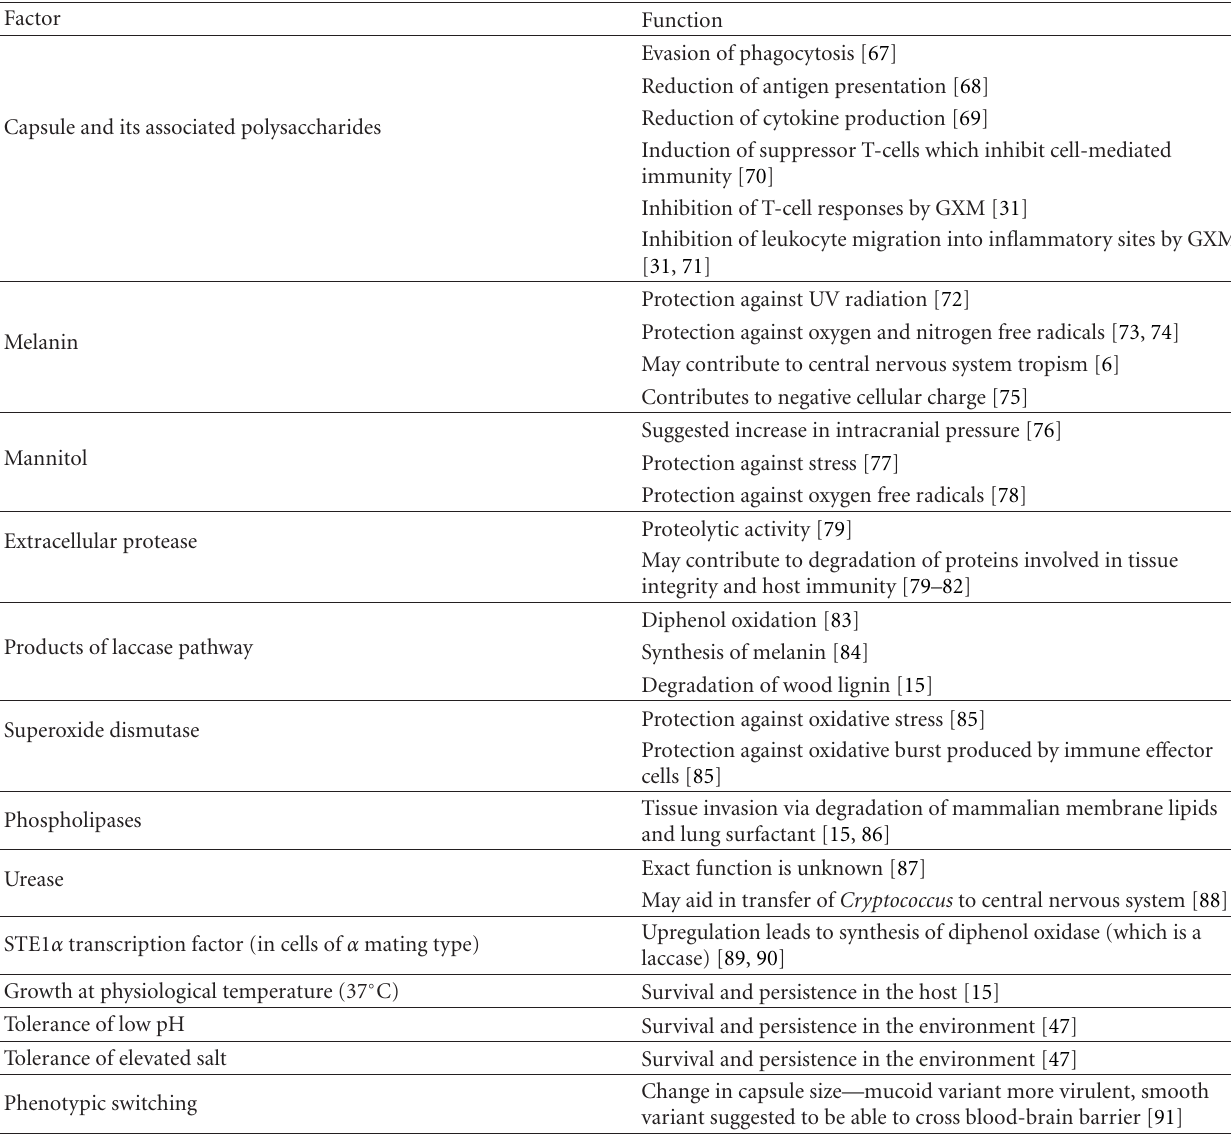
Table 1: C. gattii virulence factors and their